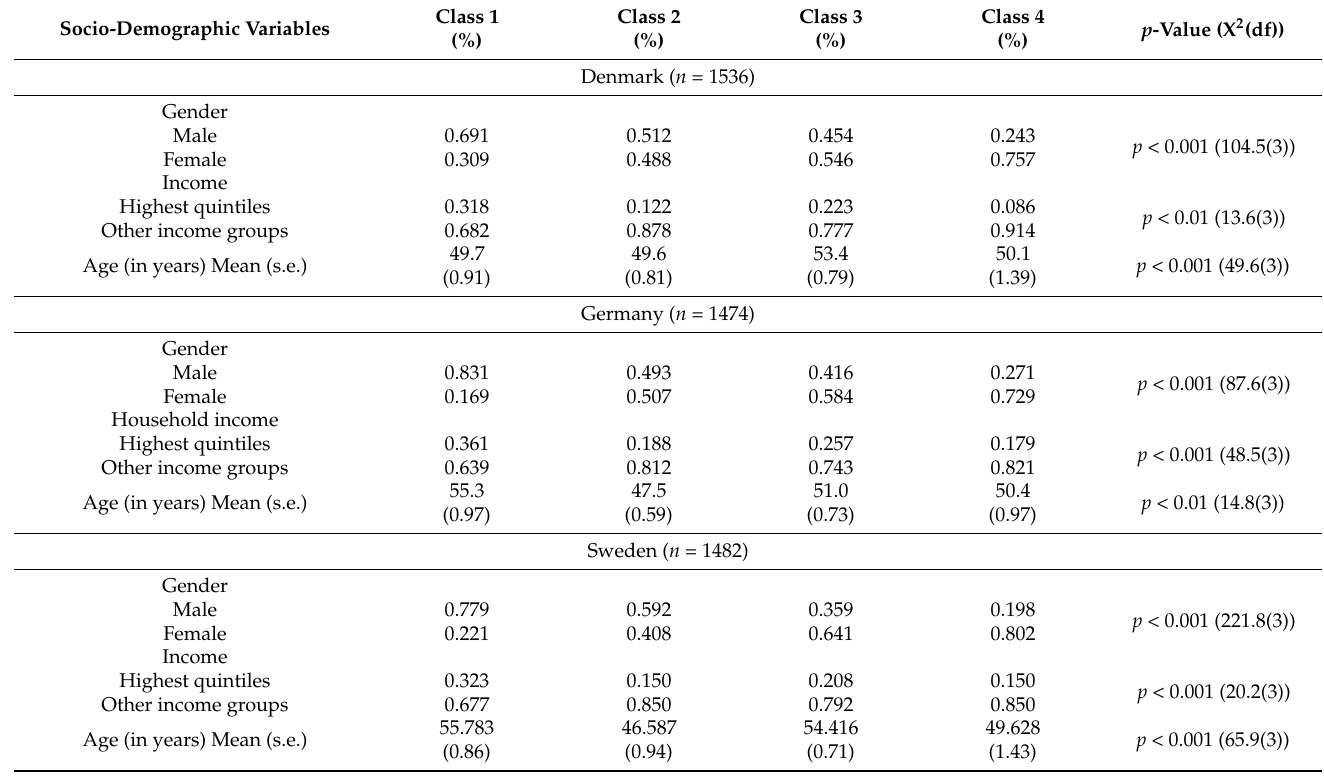
Table 5. Socio-demographic characteristics of the four pork consumer segments (shares and mean (s.e.) and test of differences). Socio-Demographic